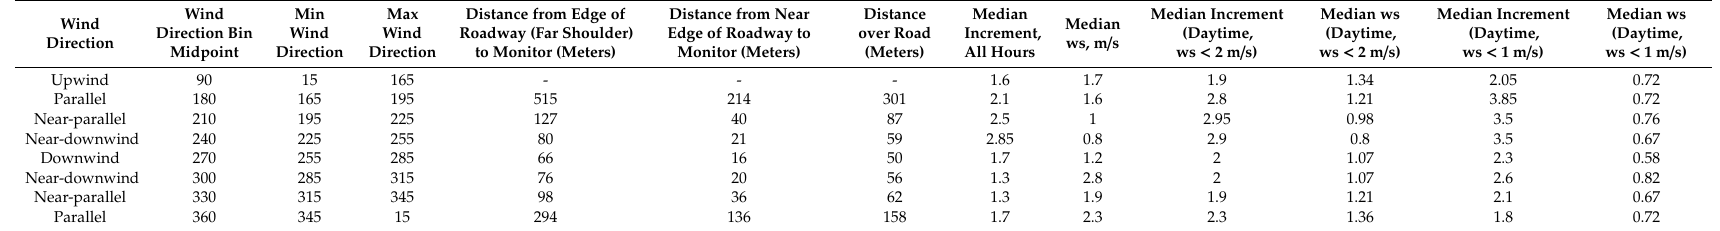
Table 1. For the Denver near-road site, distances to and over roadway, median increment (all hours, 06:00–20:00 [“daytime”] with wind speed (ws) less than 2 m / s, and daytime hours with wind speed less than 1 m / s), and median wind speeds by wind direction bins. Wind